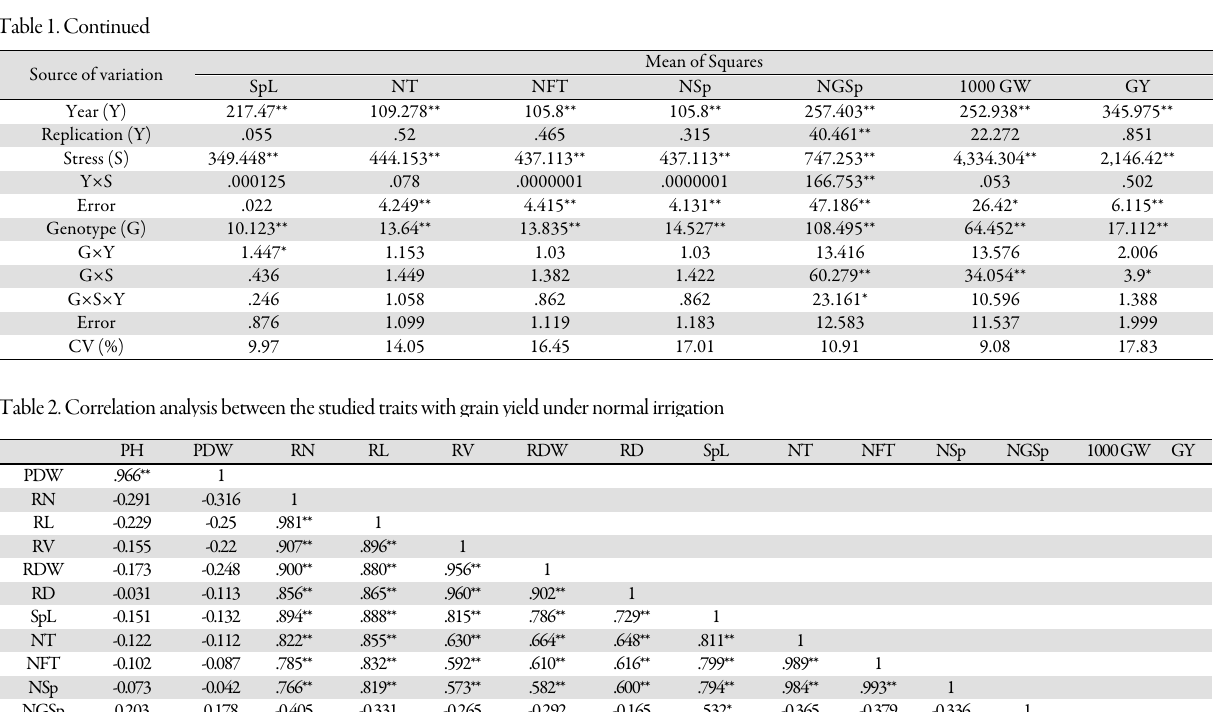
Weight, GY- Grain Yield; * and ** were significant at 5% and 1% probability levels